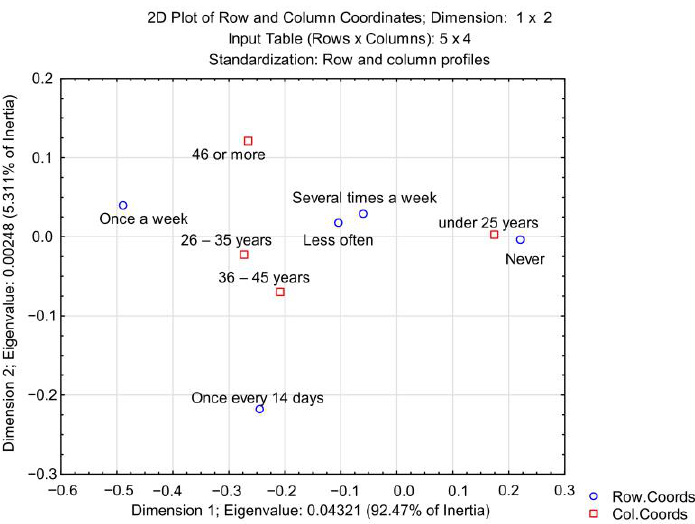
Figure 5. Correspondence maps, Markets and farmers’ markets & Respondent’s age. Source: authors.